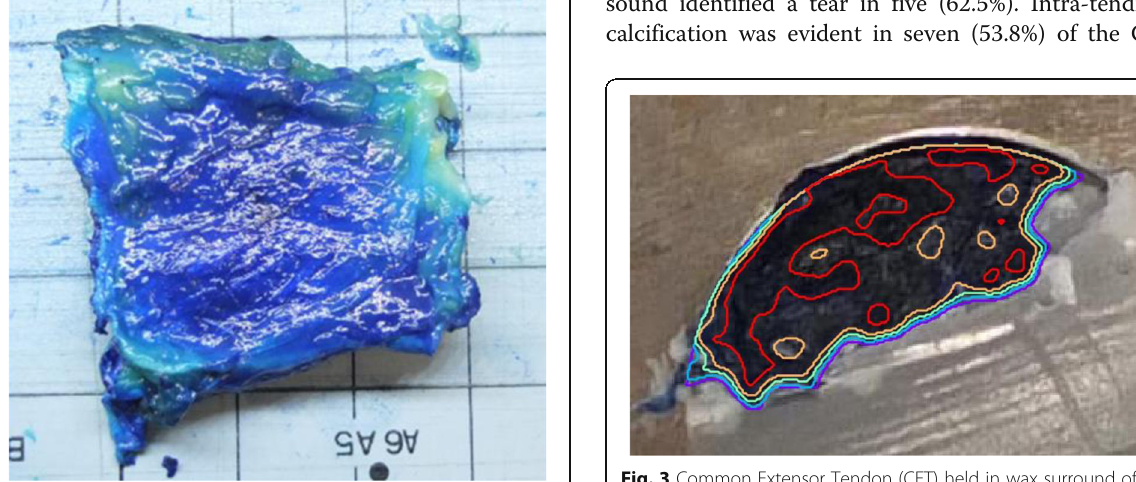
Fig. 2 Dissected Common Extensor Tendon (CET). Showing non- articular side. Blue colouration from methylene blue dye injection